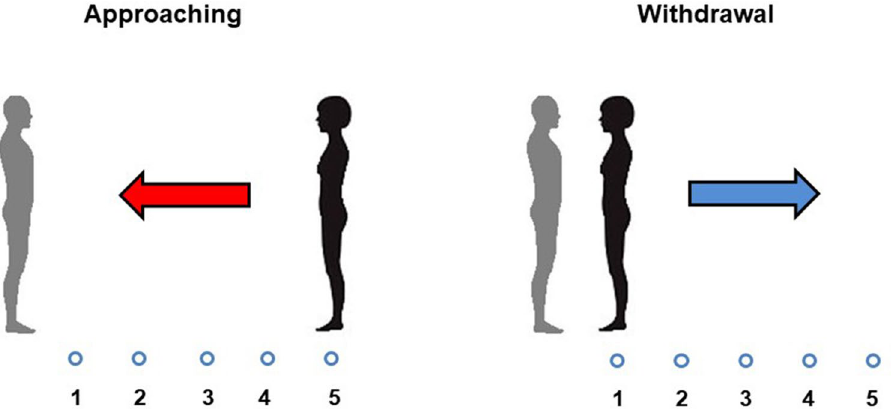
Figure 1. Schematic representation of the experimental procedure. The participant (grey) and the confederate (black) were depicted. Arrows indicate the confederate movement direction: toward the participant (approaching movement; left panel) or away from the participant (withdrawal movement; right panel) according to five different spatial positions